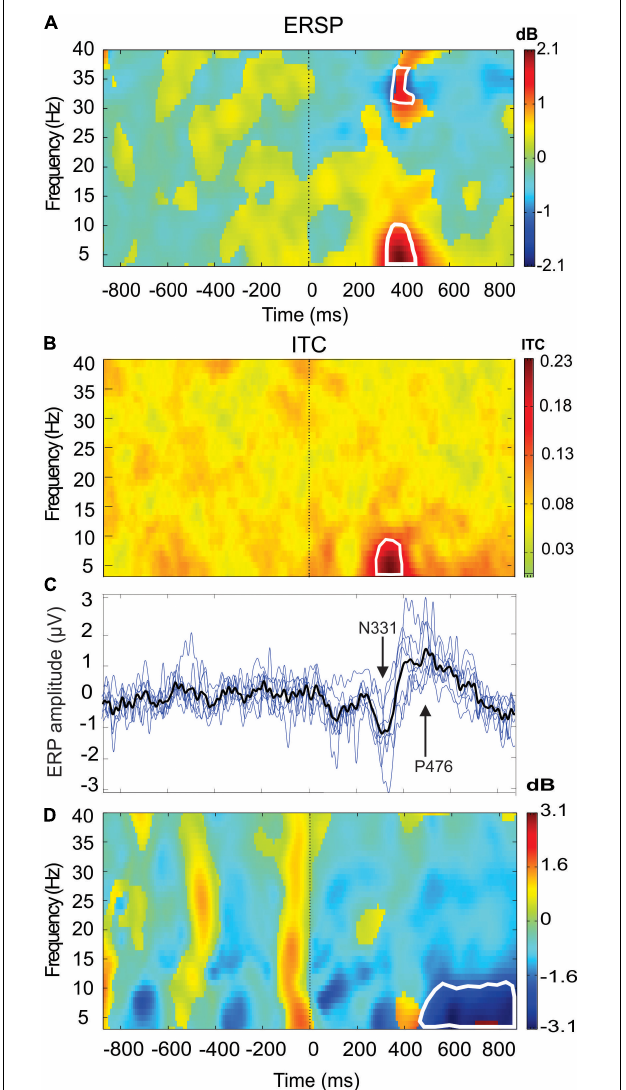
FIGURE 4 | Event-related spectral perturbation (ERSP) (A) and intertrial coherency (ITC) (B) (grand average n = 6 subjects) are recorded at the Fz electrode showing the event-related synchronization (ERS) in the delta-theta–alpha frequency bands concomitant of a theta phase-locking (red area). Also note the presence of beta-gamma ERS. In (C) , superimposition of the ERPs of the six single subjects (blue lines) ( n = 214 PWL stimulation) and the grand average ERP (black line, n = 1,284). In (D) , ERSP is recorded in PO8 electrodes showing a theta–alpha event-related desynchronization (ERD) (blue area). The areas of statistical significance at p < 0.01 are marked by white squares.